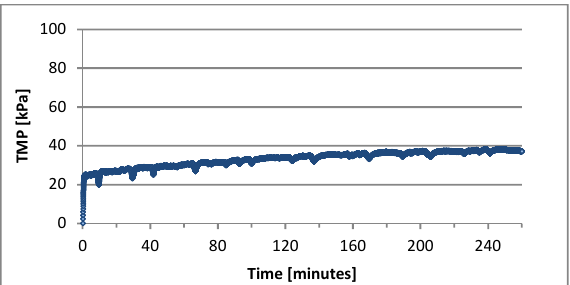
Fig. 11. TMP vs time (15 cm hollow fiber membrane, 60 LMH, CFV 33 mm/s).